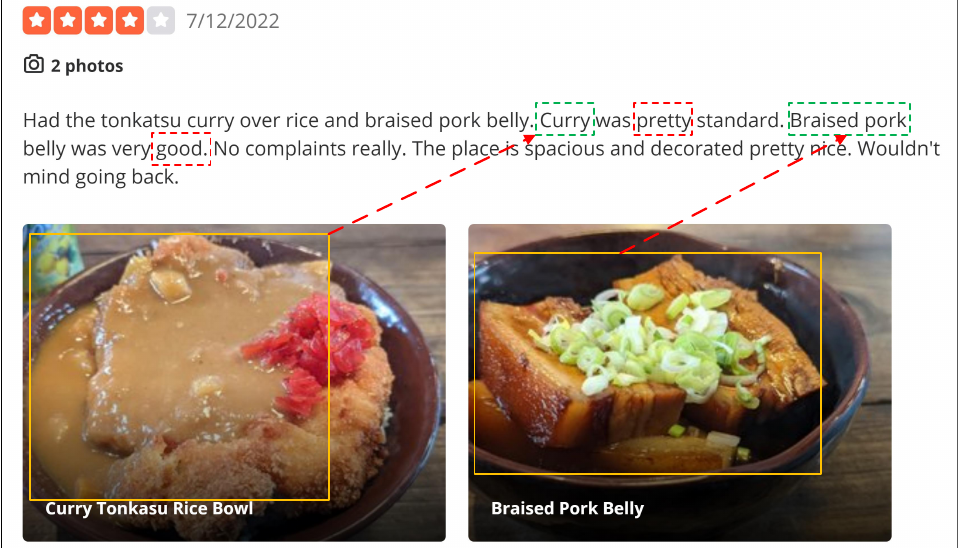
Figure 1. Example of text-image review. The entities in the image (yellow boxes) mark (red arrows) important entities in the text (green boxes) and direct us to focus on the adjectives that describe the entities (red